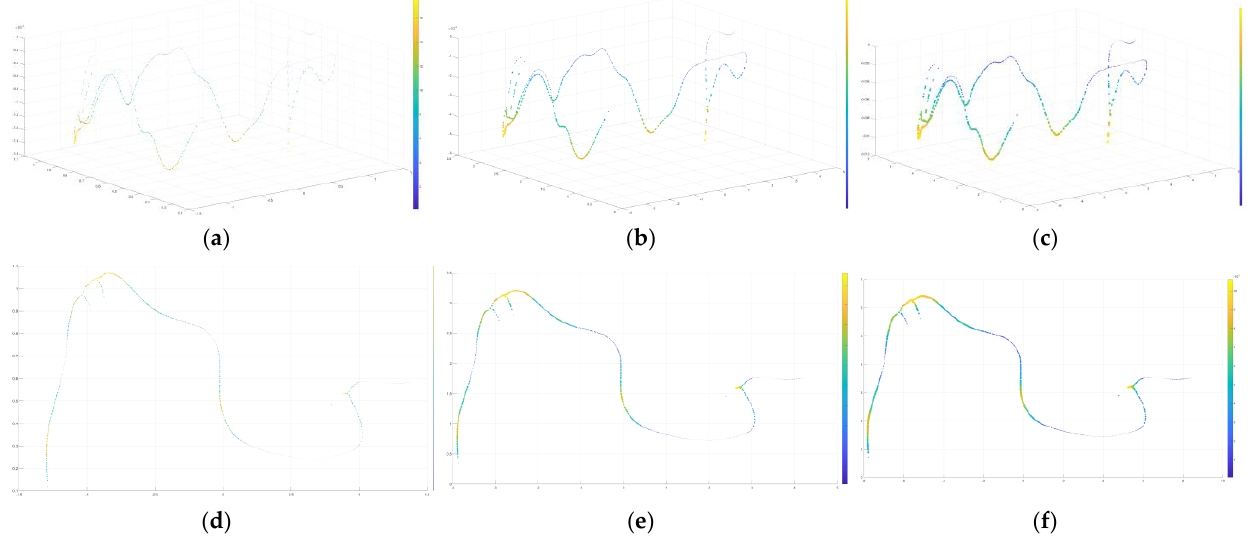
Figure 13. Changing the influencing factors. The images in the top and bottom rows are correspondences. ( a , d ), ( b , e ) and ( c , f ) correspond; the first row is the 3D view and the second row is the x − y plane view. ( b , e ) indicates the original sampling site effect; ( a , d ) shows a change in pest species and population density; ( c , f ) shows a change in host tree species and population density.